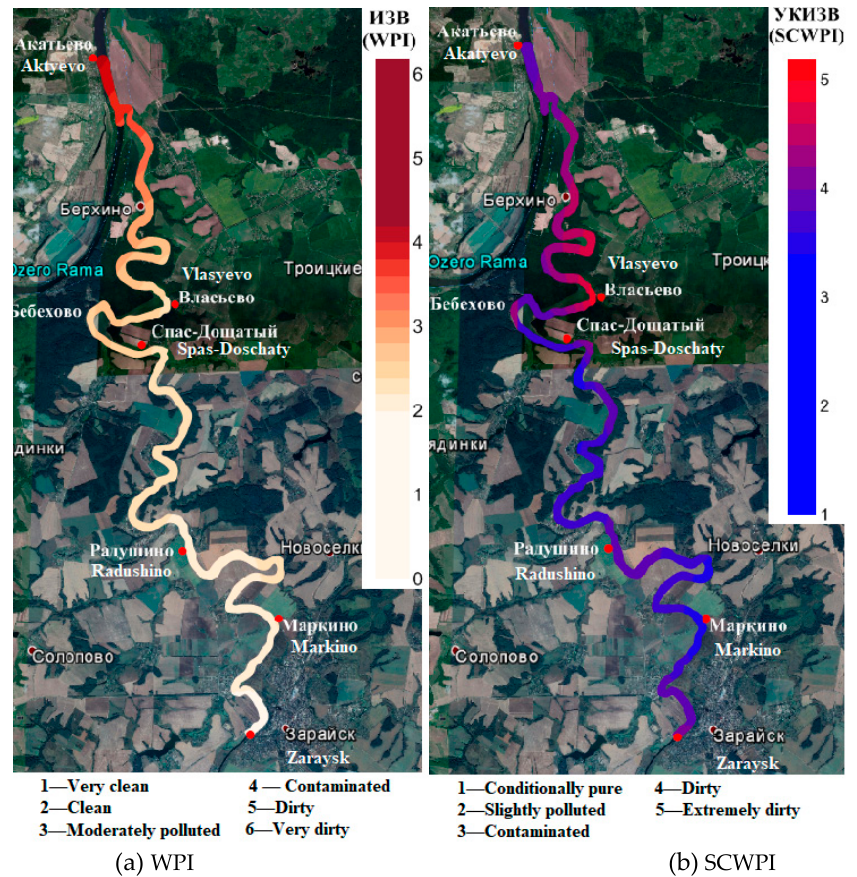
Figure 1. Map charts of the water quality change depending on the values: ( a ) water pollution index (WPI); ( b ) specific combinatorial water pollution index (SCWPI).